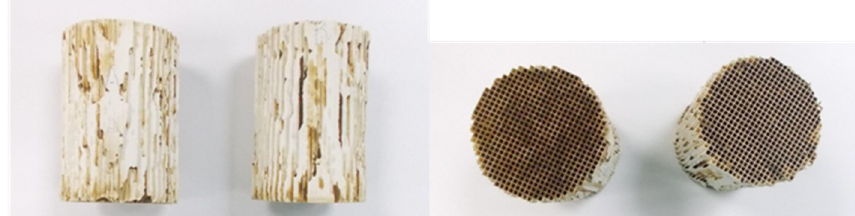
Figure 1. Representative pictures of the carrots produced (PLDOC sample).